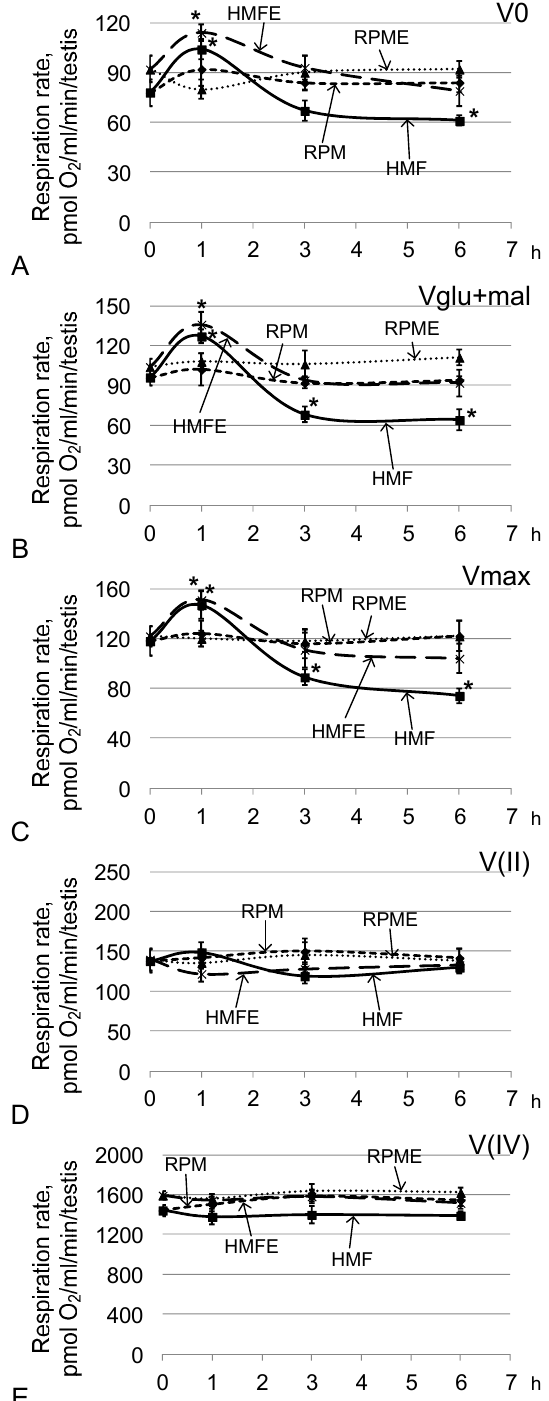
Figure 5. Testis respiration rate after fly exposure under hypomagnetic and microgravity conditions. ( A ) V0, respiration rate of permeabilized cells; ( B ) Vglu + mal, respiration rate after adding 10 mM glutamate + 5 mM malate; ( C ) Vmax, maximum respiration rate after adding 2 mM ADP; ( D ) V(II), respiration rate after adding 0.5 μ M rotenone (complex I inhibitor) and the subsequent supplement 10 mM succinate (substrate of complex II); ( E ) V(IV), respiration rate after adding 5 μ M antimycin (complex III inhibitor) and the subsequent supplement 0.5 mM TMPD + 2 mM ascorbate (artificial substrates of complex IV). * p < 0.05 compared with the corresponding control group.